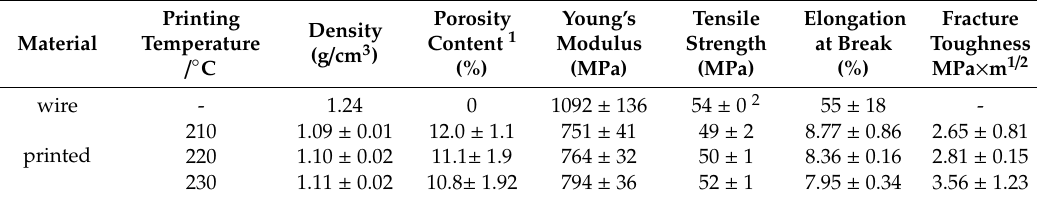
Table 1. Main mechanical parameters of as received wire and 3D-printed PLA as a function of printing temperature.